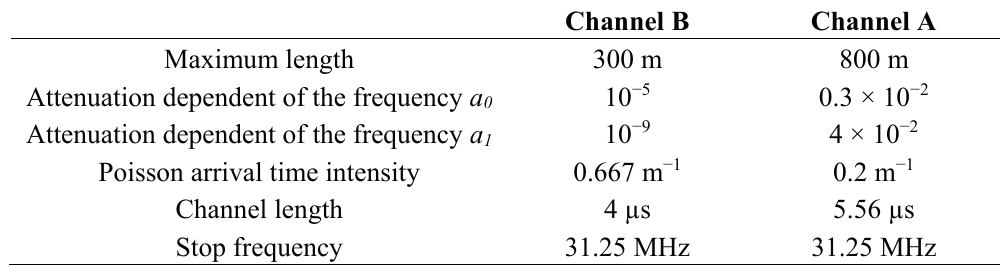
Table 4. Parameters for the PLC channel model considered here